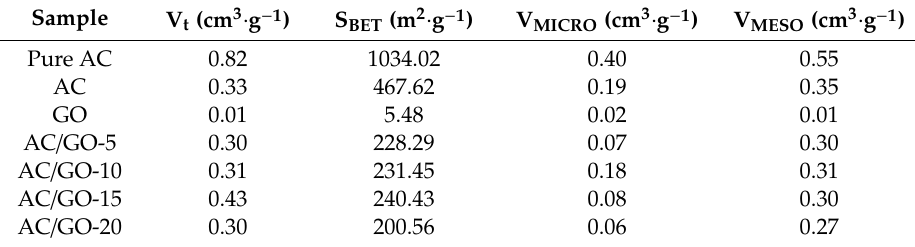
Table 2. Textural parameters of AC, GO and AC / GO-x.